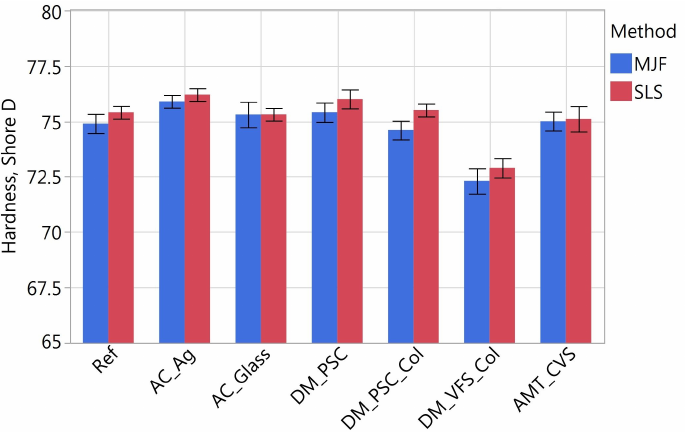
Figure 17. Hardness of MJF and SLS